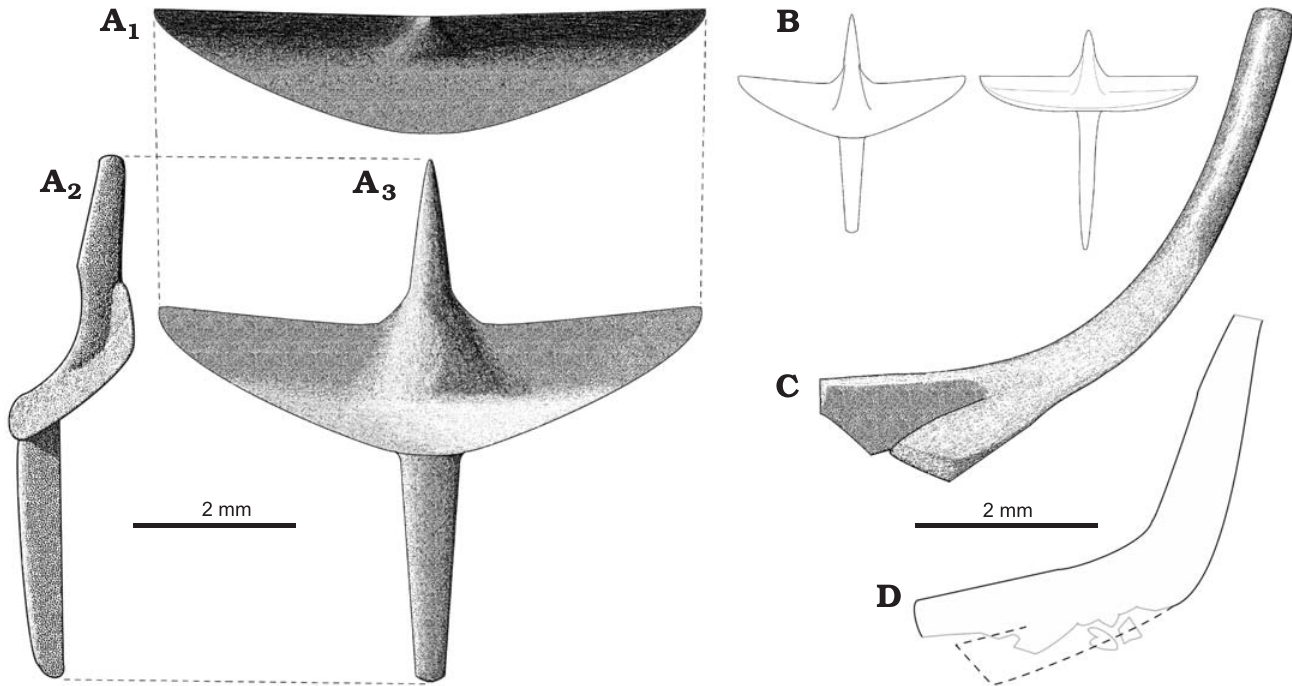
Fig. 2. Reconstructions of clavicles (C, D) and interclavicles (A, B) of Slavoia darevskii . A . Morphotype I based on ZPAL MgR-I/8, in anterior (C 1 ), lateral (C 2 ), and ventral (C 3 ) views. B . Comparison of the morphotypes II and I in the same scale. C . Morphotype I based on ZPAL MgR-I/8. D . Outlines of the morphotype II preserved in ZPAL MgR-III/80; grey lines, damaged edges of the clavicle; dotted line, hypothetical reconstruction of missing part. Both in anterior